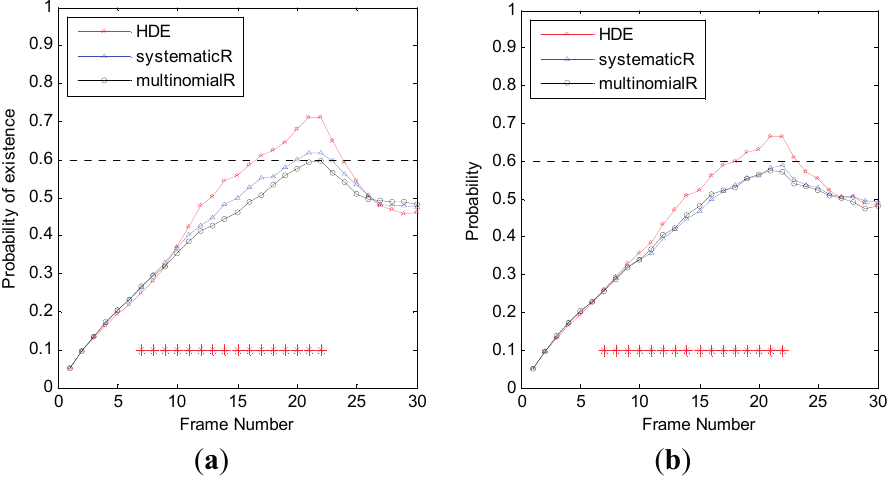
Figure 3. ( a ) Probability of existence at SNR = 0 dB for the CV model; ( b ) probability of existence at SNR = − 1 dB for the CV